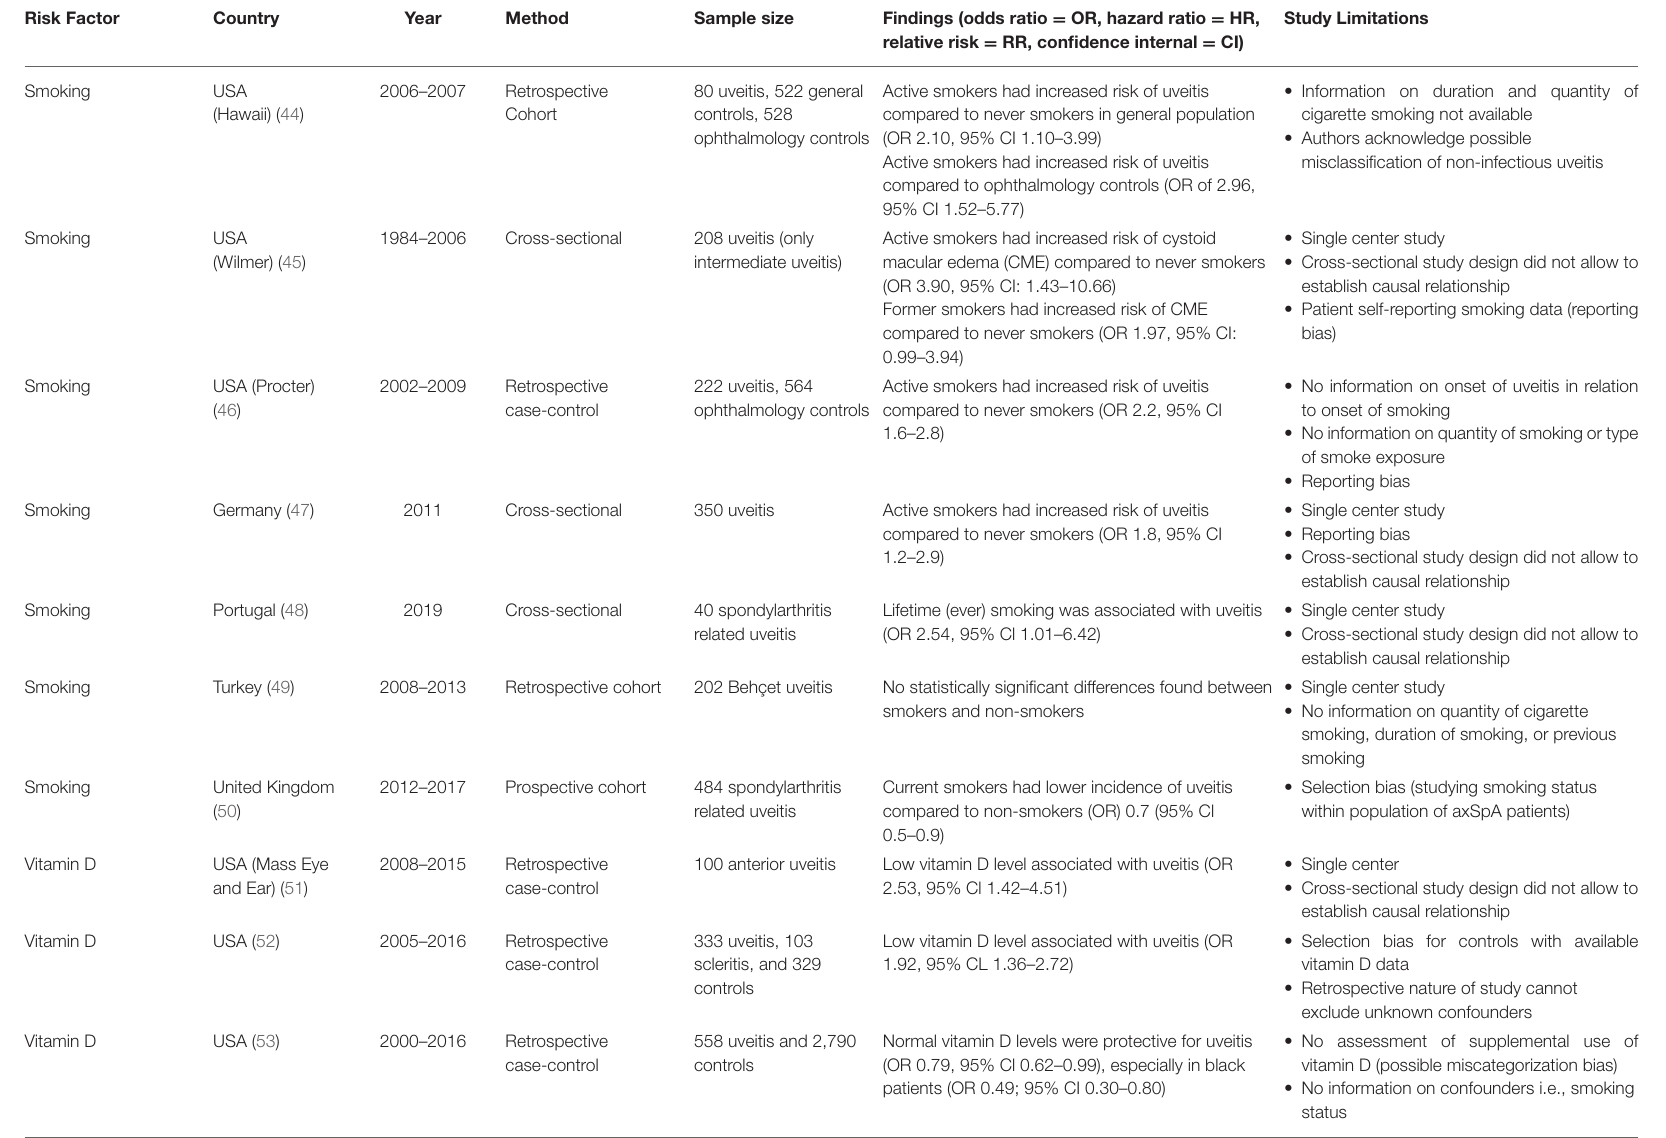
TABLE 3 | Risk Factors for Non-infectious